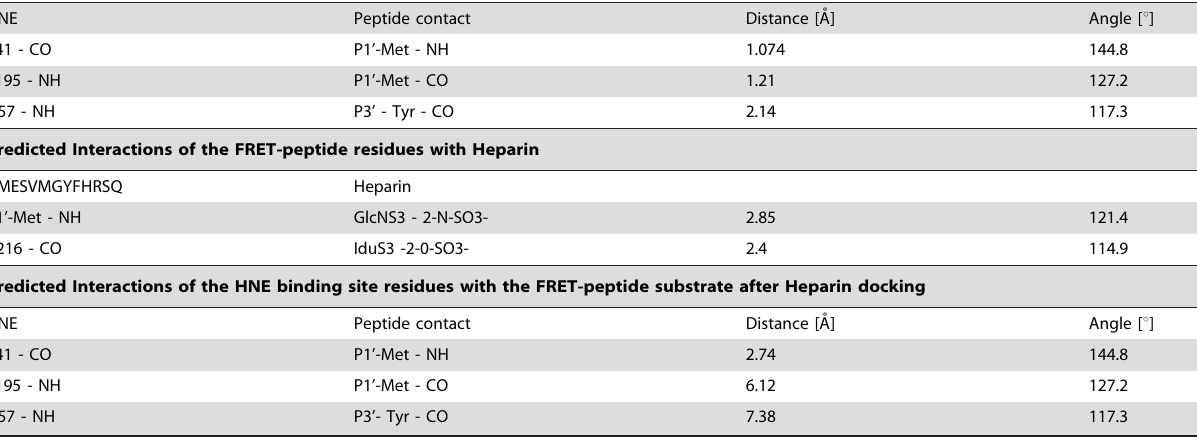
Table 4. Molecular Docking